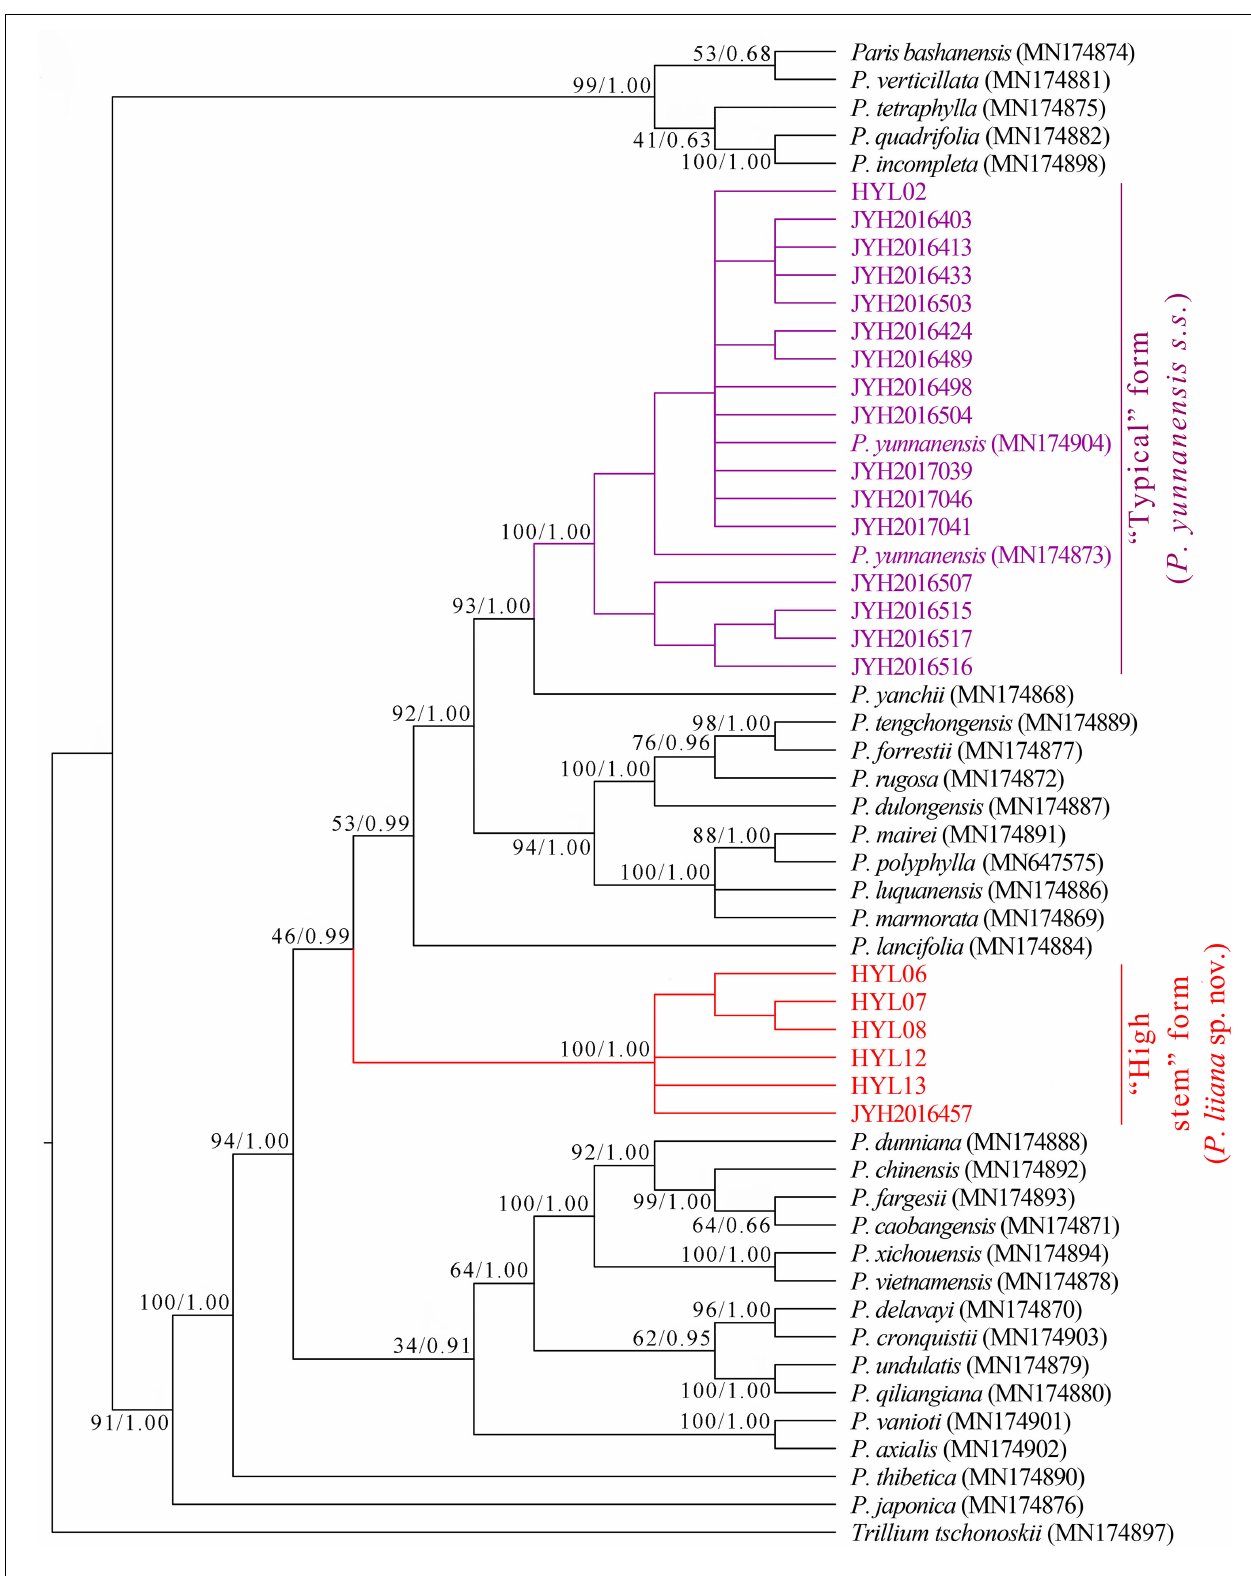
FIGURE 2 | Phylogenetic tree reconstructed via maximum-likelihood (ML) and Bayesian inference (BI) analyses of nuclear ribosomal DNA (nrDNA) sequences. Numbers above branches indicate likelihood bootstrap percentages (BP) and Bayesian posterior probabilities (PP).